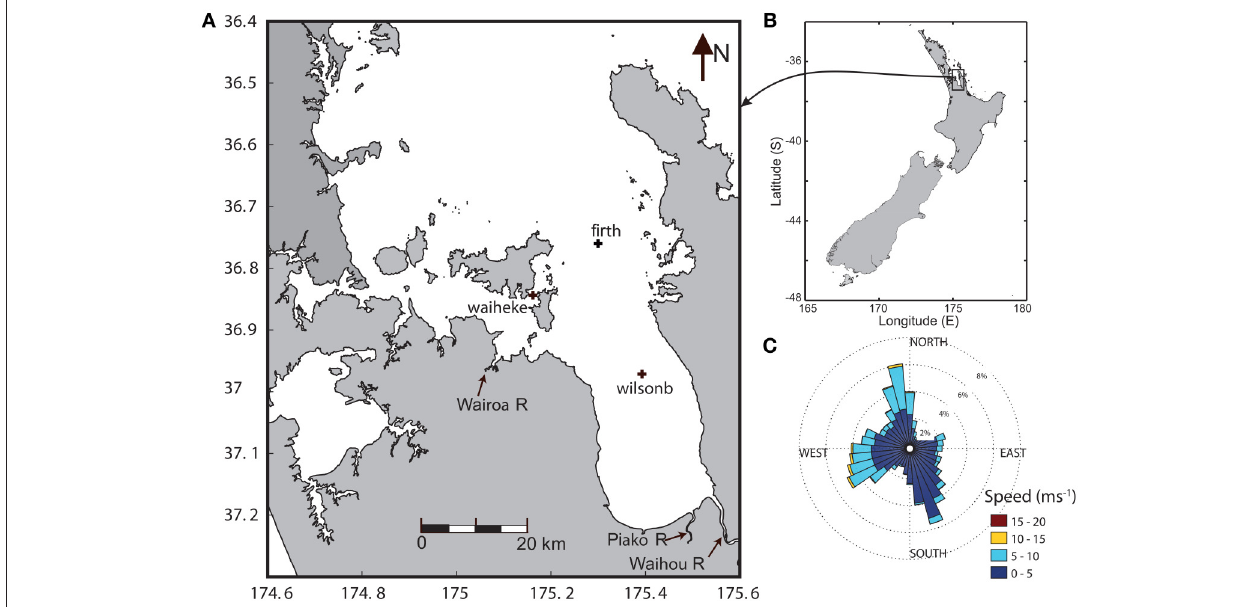
FIGURE 1 | Map of (A) Firth of Thames-Hauraki Gulf system and the location in (B) New Zealand (NZ). Shown in (A) are three mooring sites: WilsonB, Waiheke, and Firth. The three arrows in (A) indicate the Waihou and Piako rivers into the Southern Firth, and Wairoa river into Waiheke Channel. The wind rose in (C) represents an annual cycle from a weather station positioned in the SE Firth close to the Waihou river discharge location.